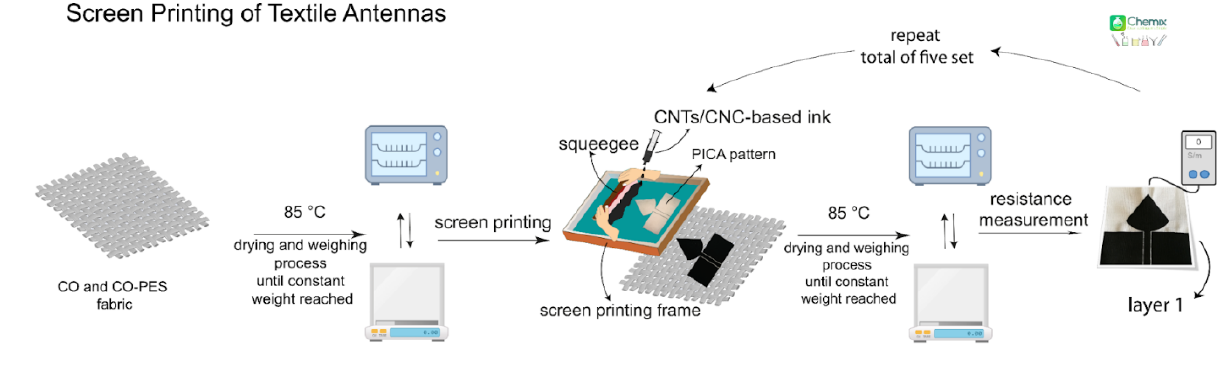
Figure 3. Schematics of screen printing of PICA and LOOP patterned textile antennas from CNTs/CNC formulations.